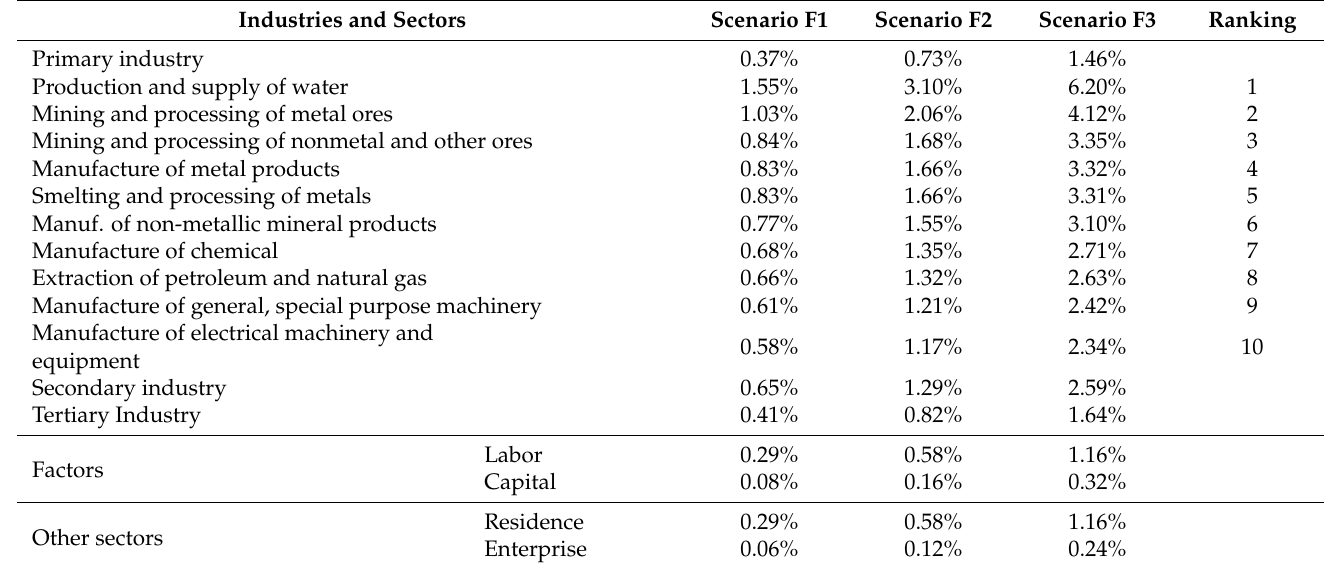
Output and income changes of various industries and sectors based on raising electricity